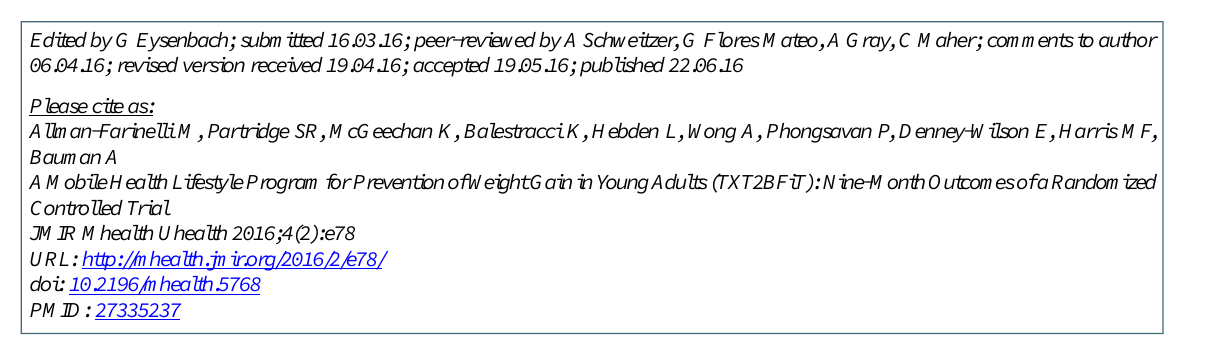
information must be